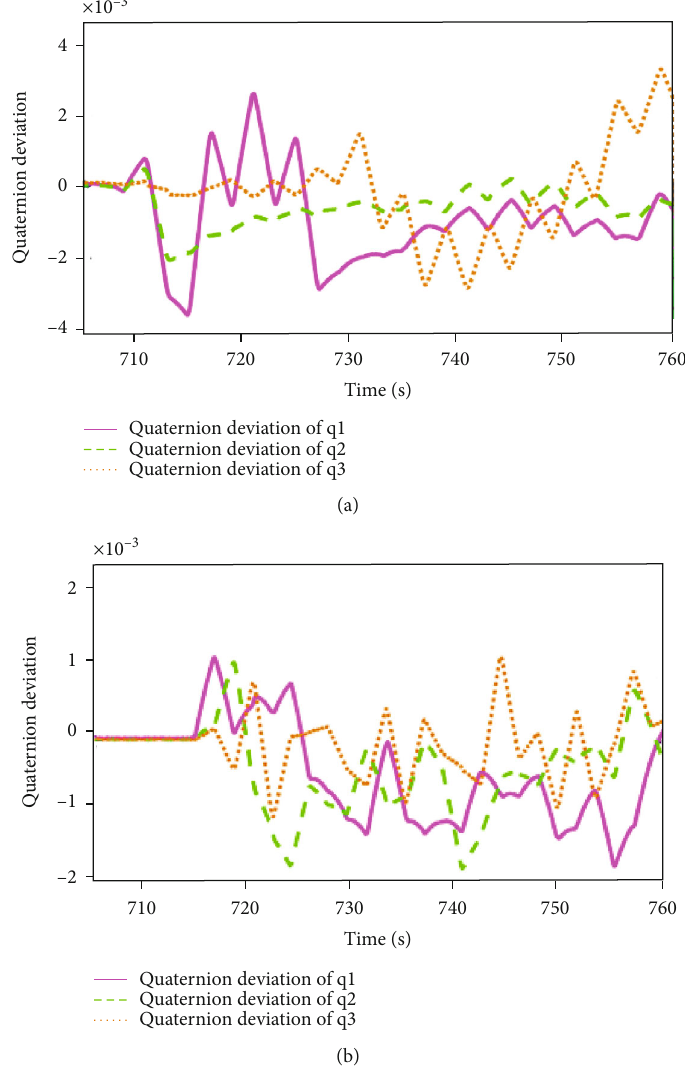
Figure 8: Quaternion deviation curve. (a) PD control. (b) Neural network sliding mode